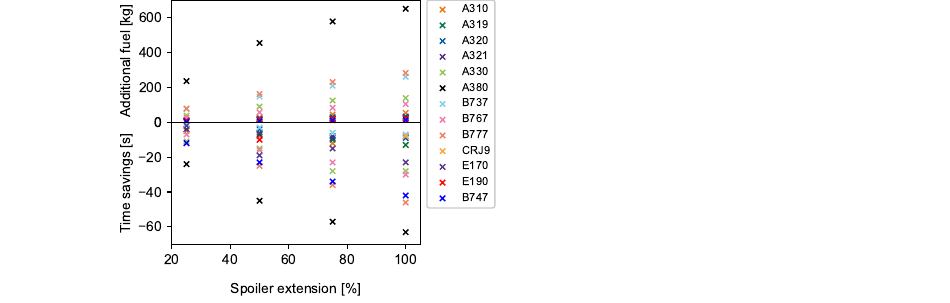
Figure 8. Change in fuel consumption ( top ) and time savings ( bottom ) of the entire flight as a function of the speed brake position. (Speed at 25,000 ft: 0.75 Ma; at 10,000 ft: 240 kt; deceleration path angle: 0.5 ◦ ; payload: 9 t).